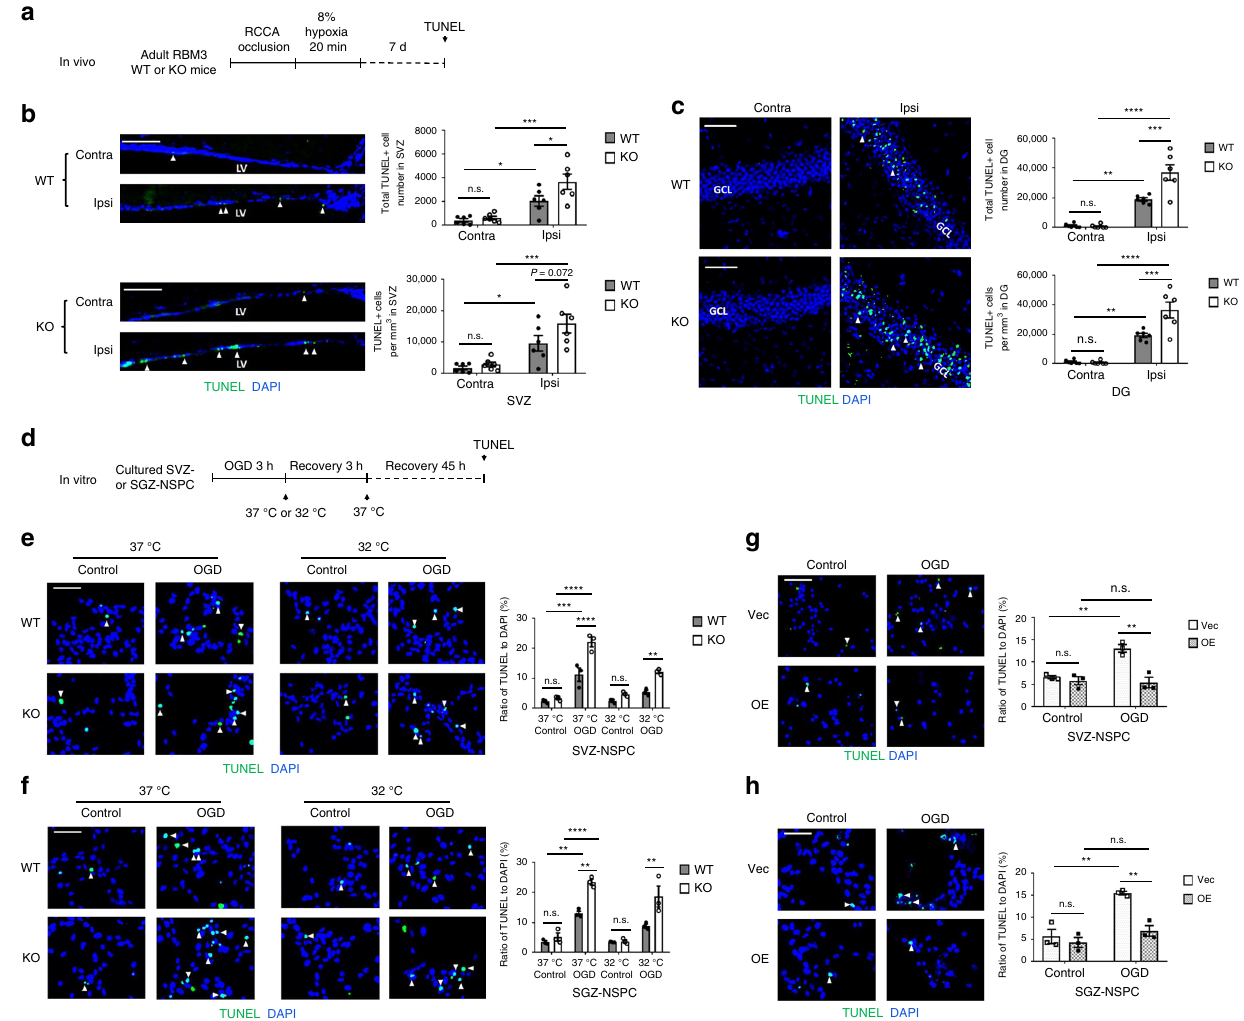
Fig. 4 RBM3 prevents HI-induced apoptosis in vivo and in vitro. a Illustration of in vivo HI model and analysis of apoptosis. RCCA right common carotid artery, TUNEL terminal deoxynucleotidyl transferase dUTP nick end labeling. b , c Representative immuno fl uorescent TUNEL staining in SVZ ( b ) or DG ( c ) of RBM3 WT and KO animals treated with HI and recovered for 7 days. Total TUNEL + cell number and density in the SVZ or DG were estimated. Six animals were counted per group ( n = 6). Scale bar: 50 µ m. Contra contralateral (uninjured side), Ipsi ipsilateral (injured side), LV lateral ventricle, GCL granular cell layer. Repeated measures two-way ANOVA was used for statistical analysis; n.s. not signi fi cant; * p < 0.05; ** p < 0.01; *** p < 0.001; **** p < 0.0001. d Illustration of in vitro OGD model and analysis of apoptosis. OGD oxygen-glucose deprivation. Only WT or KO NSPCs underwent hypothermic treatment (32 °C). Plasmid-transfected NSPCs were always cultured at 37 °C. e – h Representative immuno fl uorescent TUNEL in NSPCs after OGD stress. SVZ-NSPCs ( e ) and SGZ-NSPCs ( f ) from RBM3 WT or KO mice were treated with OGD and hypothermia as stated in Fig.1 legend, except for 48 h reoxygenation period instead of 24 h in total. The ratio of TUNEL + /DAPI + cells was quanti fi ed (three independent experiments, n = 3). Three-way ANOVA was used for statistical analysis; n.s. not signi fi cant; ** p < 0.01; *** p < 0.001; **** p < 0.0001. SVZ-NSPCs ( g ) and SGZ-NSPCs ( h ) transfected with empty vector (Vec) or RBM3 overexpression (OE) plasmid were treated with OGD and reoxygenated at 37 °C for 48 h. The ratio of TUNEL + /DAPI + cells was quanti fi ed (three independent experiments, n = 3). Scale bar: 50 µ m. Two-way ANOVA was used for statistical analysis; n.s. not signi fi cant; ** p < 0.01. All data are presented as mean ± SEM we identi fi ed more IGF2 mRNA bound to IMP2 protein after (Fig. 5g, 6c, e). On measuring the levels of IGF2 released into OGD in WT SGZ-NSPCs and an upward trend in WT SVZ- culture medium after OGD stress, we found those in SVZ-NSPC NSPCs (Fig. 6c, d). In the absence of RBM3, enrichment of bound conditioned medium to be less than 50% of those in SGZ-NSPC IGF2 mRNA was clearly reduced in SGZ-NSPCs after OGD when counterpart (Fig. 6f, g). IGF2 secretion into SGZ-NSPC culture comparing to WT, but unchanged in SVZ-NSPCs (Fig. 6c, d). medium was signi fi cantly induced by OGD but reduced by RBM3 Interestingly, endogenous IGF2 protein levels were reduced depletion (Fig. 6g). Conversely, RBM3 expression had no effect instead of enhanced after OGD in SGZ-NSPCs, probably due to on IGF2 release into SVZ-NSPC culture medium (Fig. 6f). increased secretion (Fig. 6e). When RBM3 was depleted, Overall, hypothermia inhibited IGF2 secretion in both SVZ- and endogenous IGF2 protein decreased in SGZ-NSPCs after OGD SGZ-NSPCs after OGD, probably by reducing its expression level (Fig. 6e). IGF2 protein levels in SVZ-NSPCs were not signi fi cantly (Fig. 6f, g). affected by either OGD or RBM3 depletion, consistent with the Additionally, we noticed that the intensity of IGF2 protein unchanged IGF2 mRNA data and the trend of IMP2 protein expression was enhanced in the ipsilateral SGZ but not SVZ in NATURE COMMUNICATIONS| (2019) 10:3983